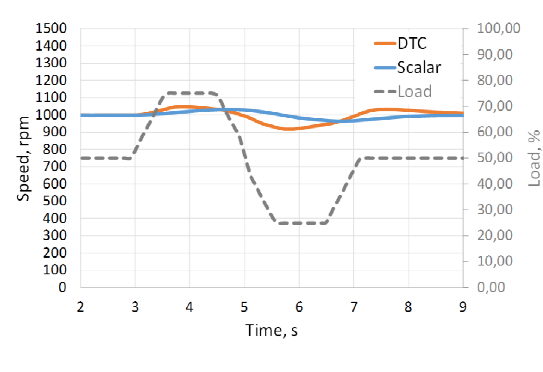
Fig. 12. Drive speed response on variable load of trapeze profile.